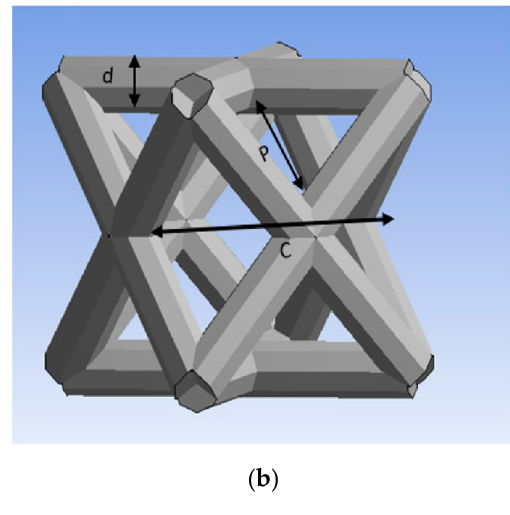
Figure 1. Unit cells: ( a ) cubic, ( b ) diagonal.